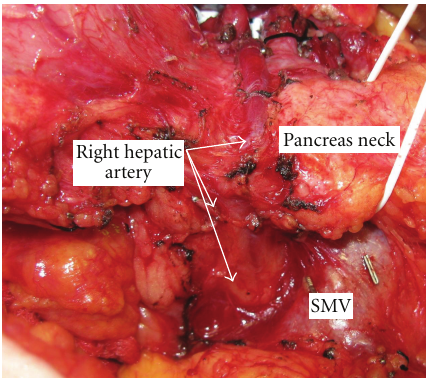
Figure 3: Intraoperative photograph of pancreas head in Case 2 with replaced right hepatic artery embedded in the anterior face of the